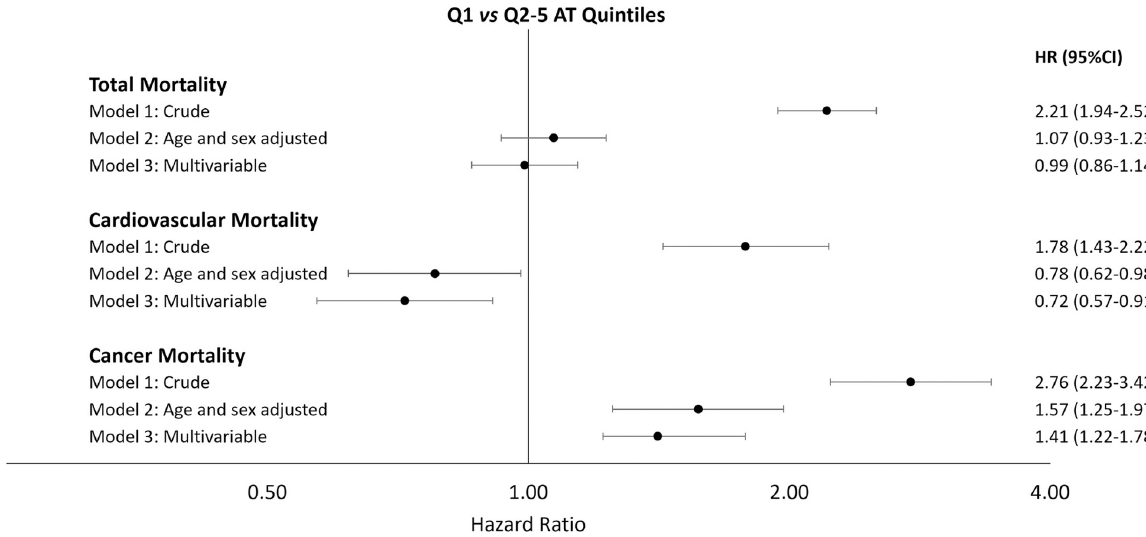
Fig 3. Hazard ratios (95% CI) for total, cardiovascular and cancer mortality comparing Q1 (AT < 94.3%) vs Q2-5 (AT � 94.3%), in the Moli- sani population (n = 19,676). (HR 3.26, 95% CI: 2.34–4.55, model 1 and HR Q1vsQ5